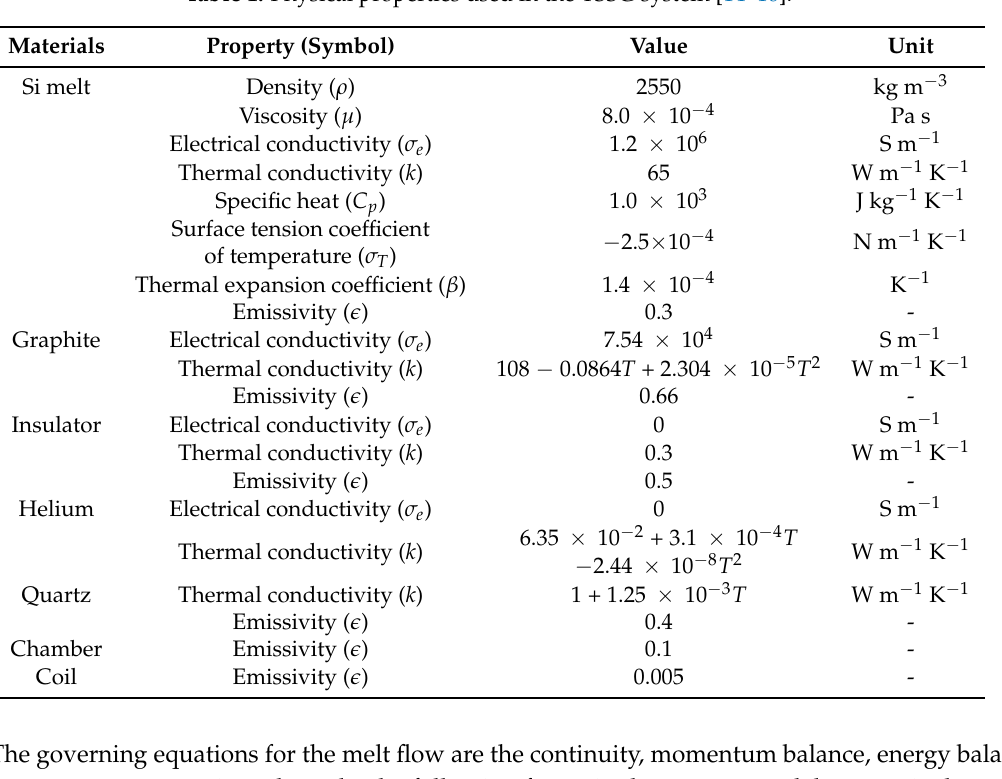
Table 1. Physical properties used in the TSSG system